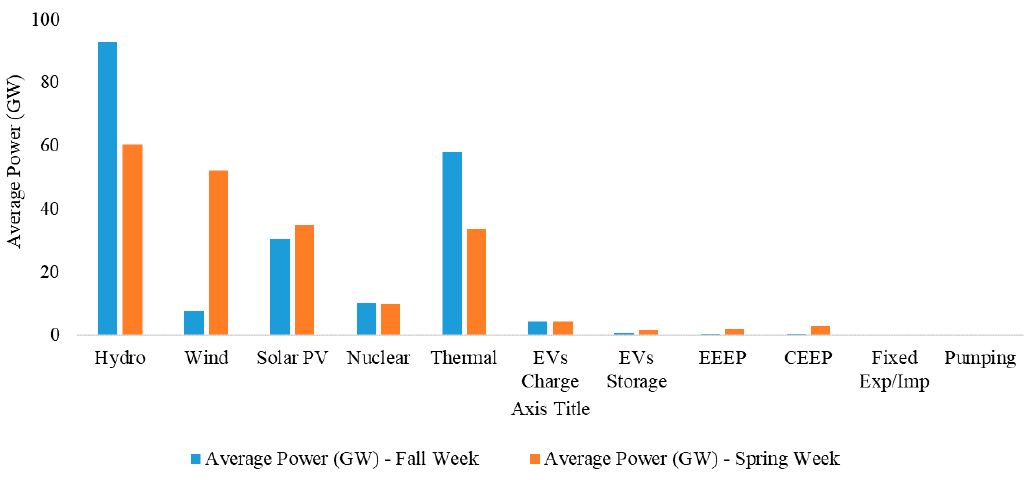
Figure 8. Average power output on a spring and fall week for scenario hydro risk.